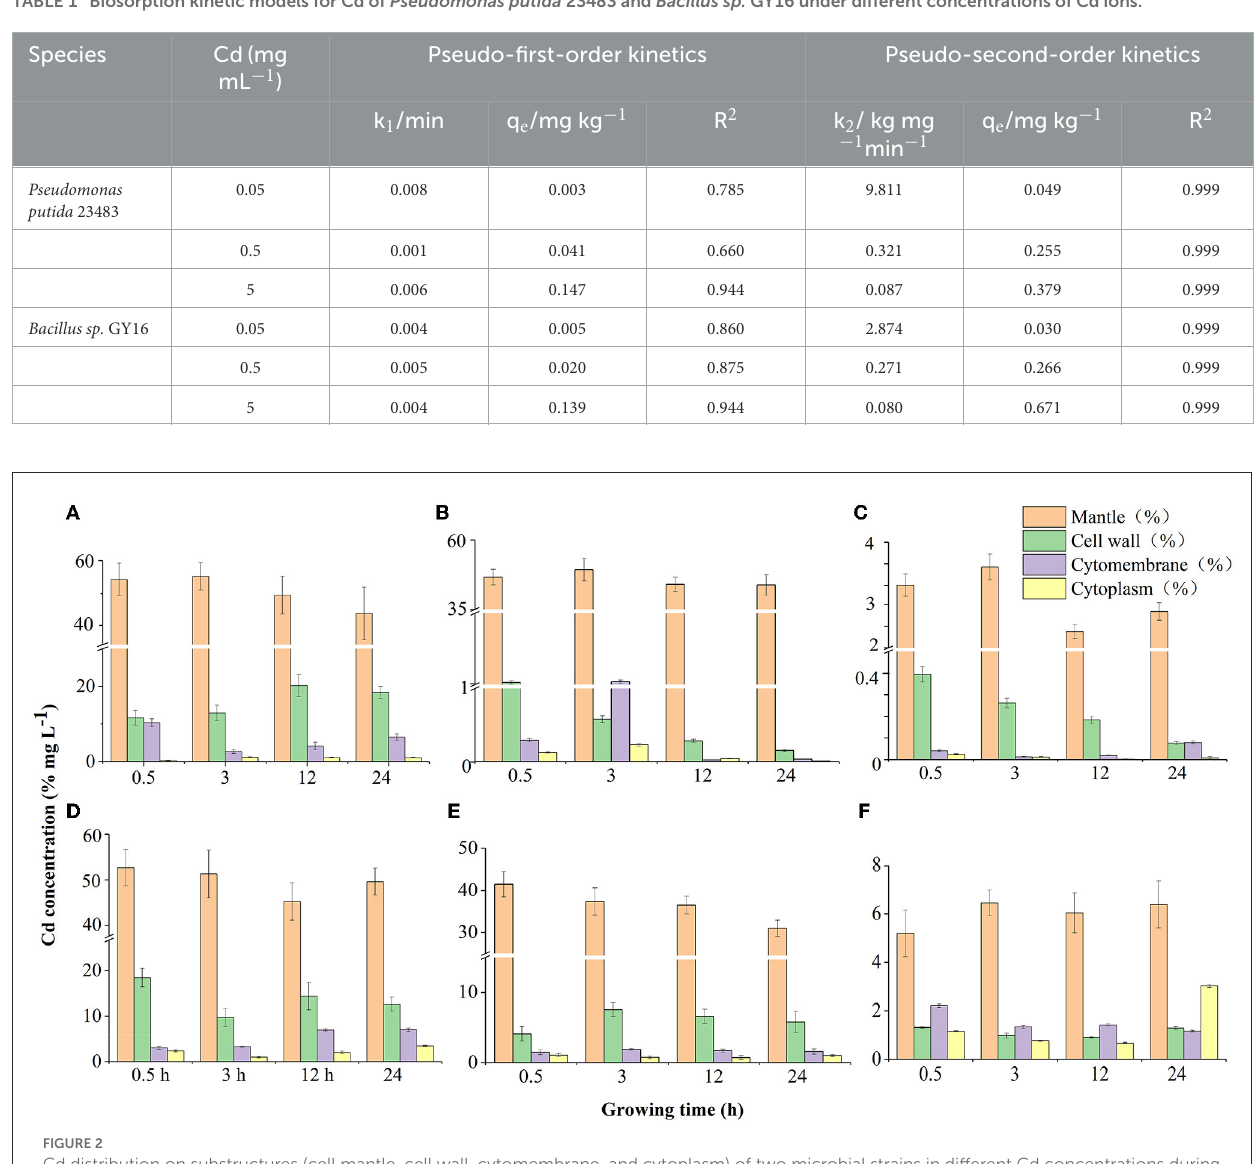
FIGURE2 Cd distribution on substructures (cell mantle, cell wall, cytomembrane, and cytoplasm) of two microbial strains in different Cd concentrations during sorption time (0.5, 3, 12, and 24h). (A–C) Cd sorption by Pseudomonas putida 23483 in concentrations of 0.05, 0.5, and 5mg L − 1 , respectively. (D–F) Cd sorption by Bacillus sp. GY16 in concentrations of 0.05, 0.5, and 5mg L − 1 ,